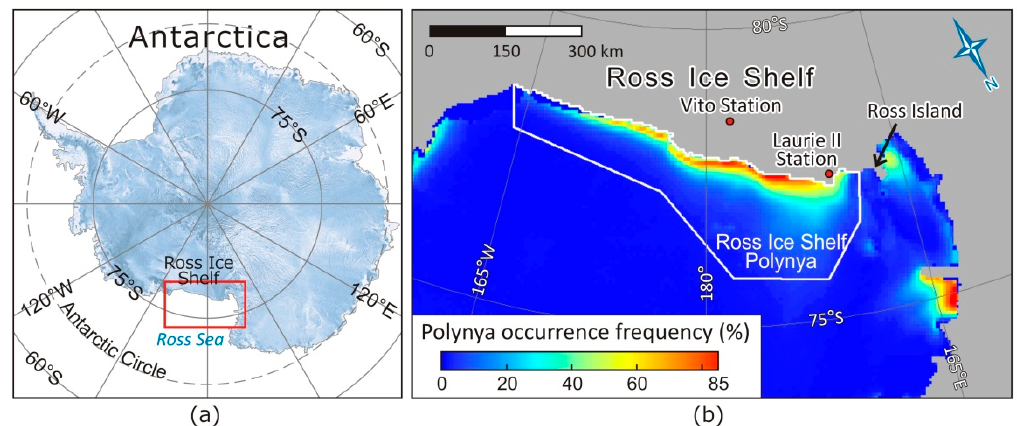
Figure 1. ( a ) Location map of the study area. The red rectangle indicates the location of ( b ). ( b ) Spatial distribution map of the Ross Ice Shelf Polynya (RISP) occurrence frequency. The study area is enclosed by the white line. Two Automatic Weather Stations are marked by red points.